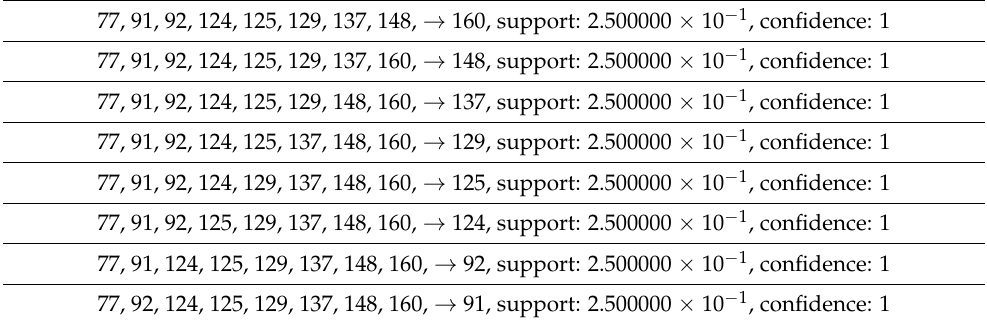
Table 2. Samples of mined ARs.